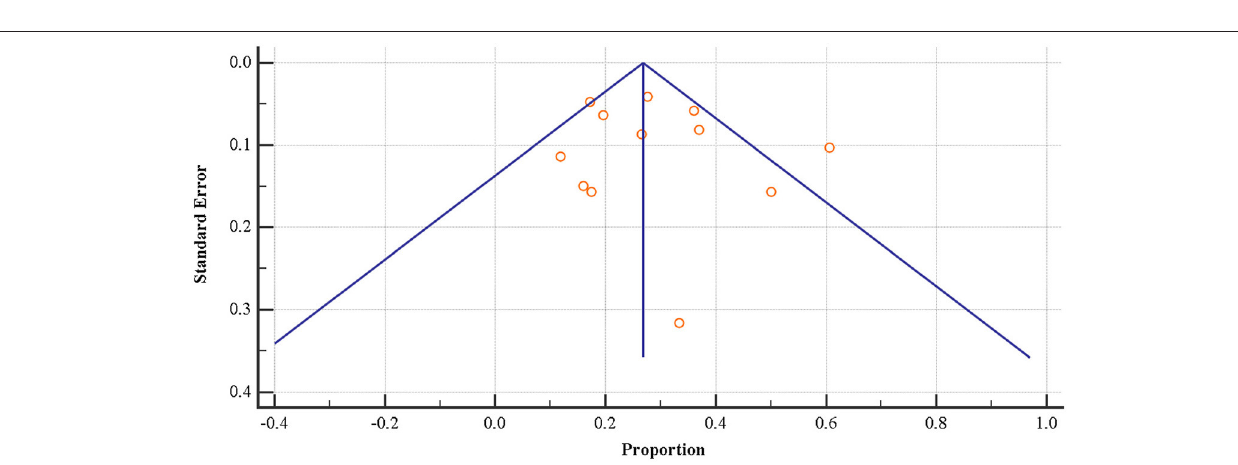
FIGURE 2 | Funnel plot of the prevalence rate of emotional exhaustion among physical education teachers.